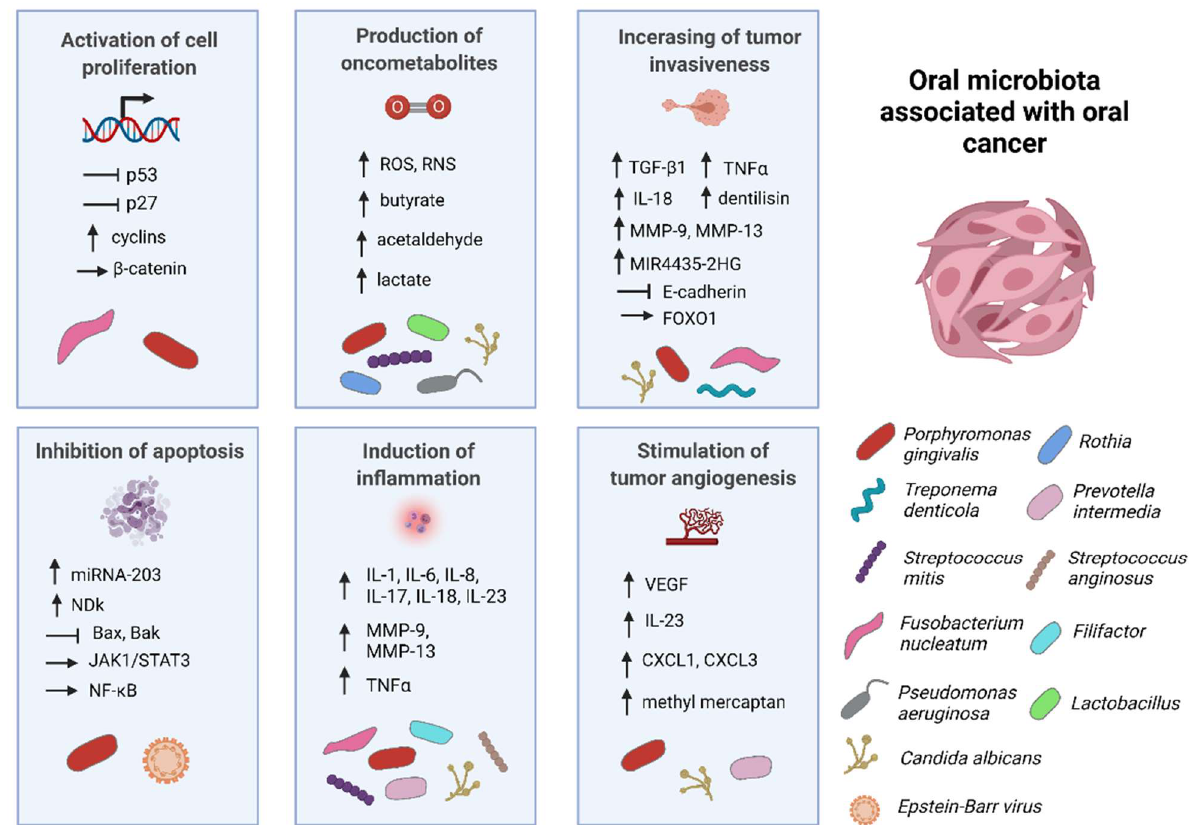
Figure 1. Graphical representation of the mechanisms via which selected microorganisms may be associated with oral squamous cell carcinoma (OSCC). The described mechanisms are discussed in detail in this review. Abbreviations: ROS, reactive oxygen species; RNS, reactive nitrogen species; TGF-β1, transforming growth factor beta 1; TNFα, tumor necrosis factor α; IL, interleukin; MMP-9, matrix metalloproteinase-9; MMP-13, matrix metalloproteinase-13; FOXO1, forkhead box O1; NDk, nucleoside diphosphate kinase; JAK1/STAT3, janus kinase 1/signal transducer and activator of transcription 3; VEGF, vascular endothelial growth factor; CXCL1, C–X–C motif chemokine 1; CXCL3, C–X–C motif chemokine 3; NF-κB, nuclear factor kappa B.